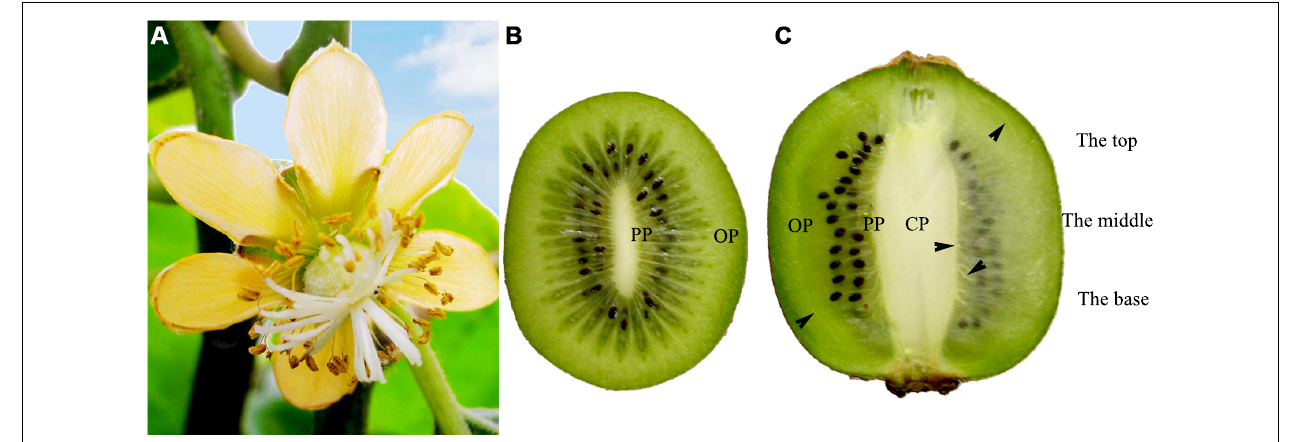
FIGURE 1 | Female flower and fruits of Actinidia deliciosa var deliciosa ‘Qinmei.’ (A) A female flower, showing syncarpous pistil constituted by many carpels. (B) Mid-cross section of fruit, showing many carpels around the axile